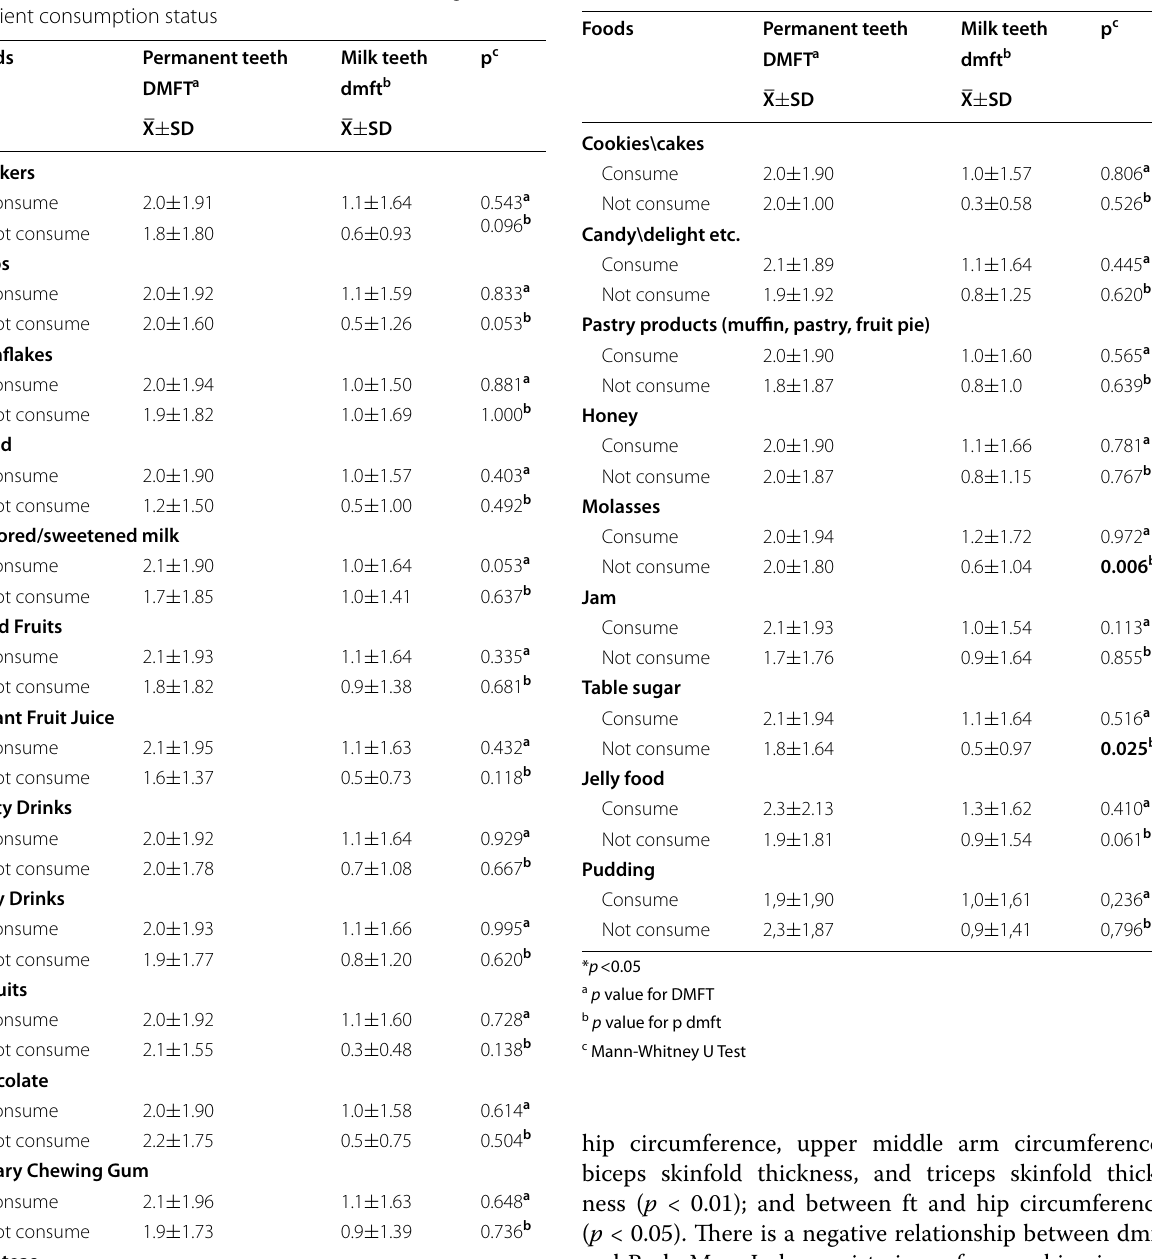
Table 4 Oral health indicators of children according to